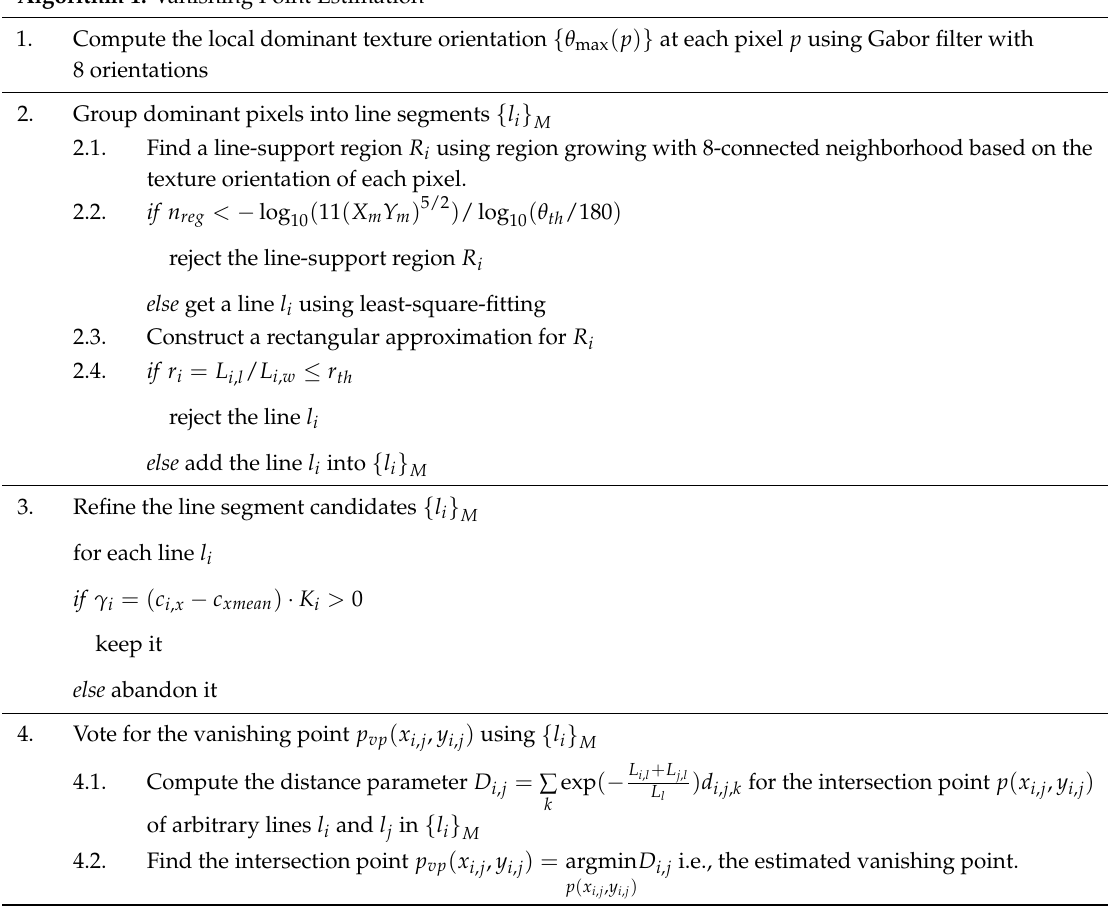
Algorithm 1. Vanishing Point